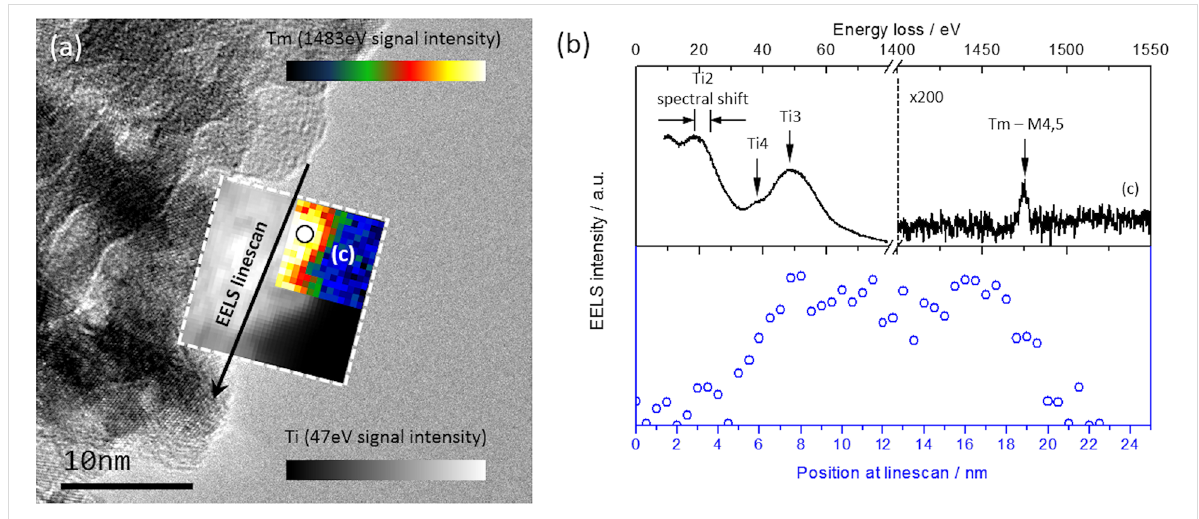
Figure 7: (a) TEM image of the 5.8 atom % Tm-doped sample annealed at 973 K and EELS maps obtained for the Ti3 peak (grey scale map) and Tm-M 4,5 signal (temperature map). (b) EELS spectra obtained at position (c) of Figure 7a and the Tm-M 4,5 signal intensity profile along the corres- ponding linescan of Figure